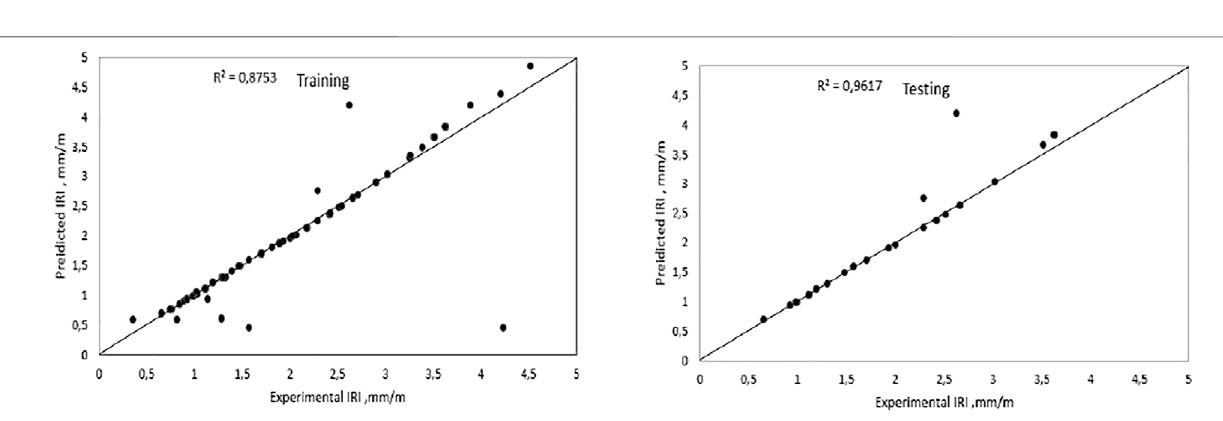
FIGURE 12 | The regression plot of predicted model 2 IRI against experimental IRI for testing and training data.